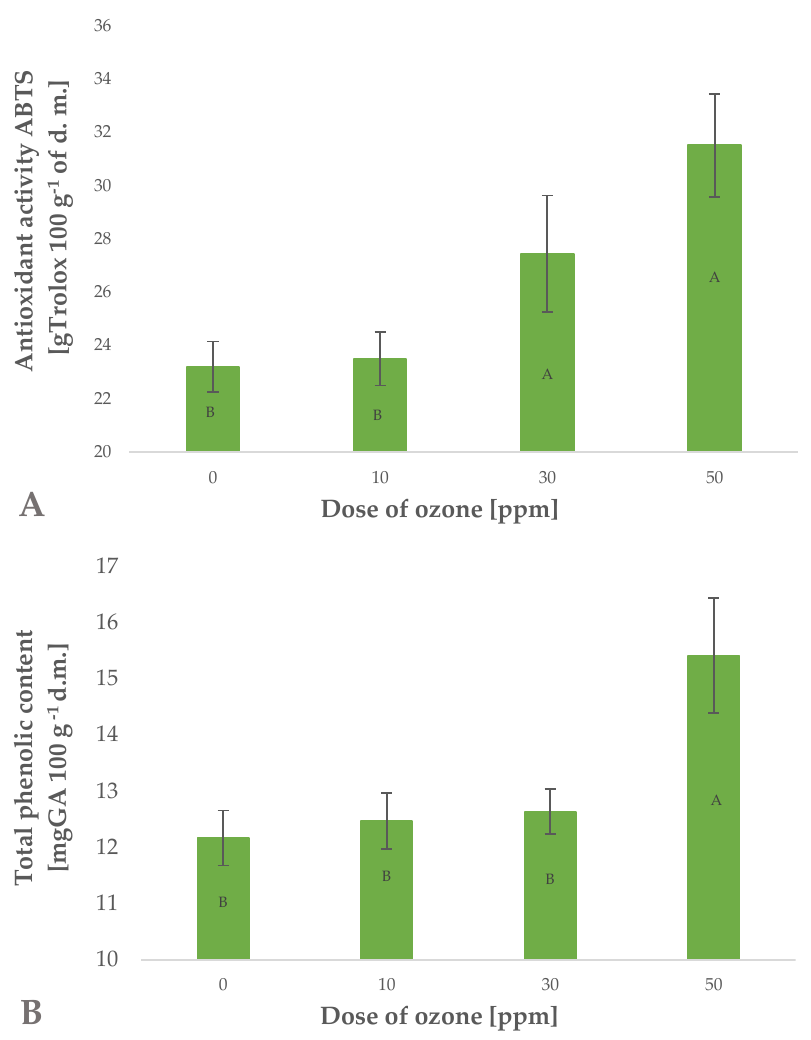
Figure 2. Antioxidant activity ABTS ( 2,2′ -Azino-bis-(3-ethylbenzothiazoline-6-sulfonic acid) test ( A ) and total polyphenolic content ( B ) in barley young plants depending on the dose of ozone ( n = 20): differences between the results for the dose of ozone treatment are marked with capital letters; significance level is defined as p < 0.05.